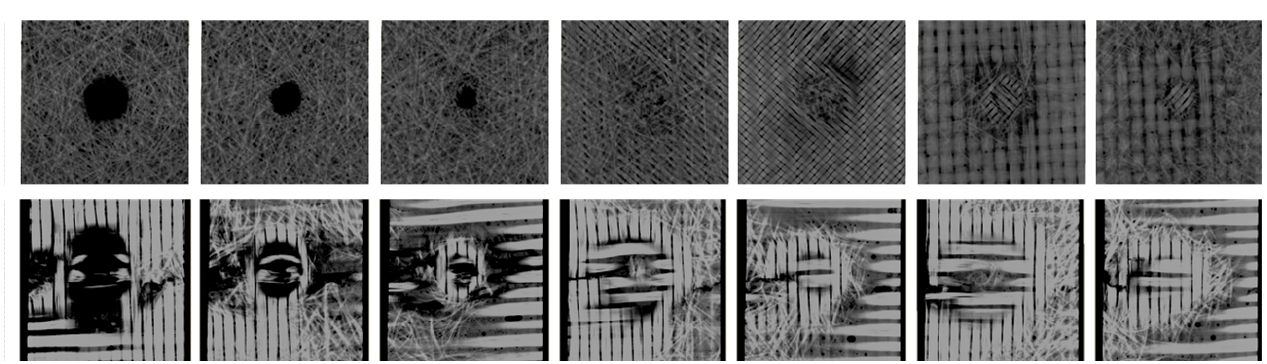
Figure 8: Tomograms of laminated specimens impacted at energy of 126 J.